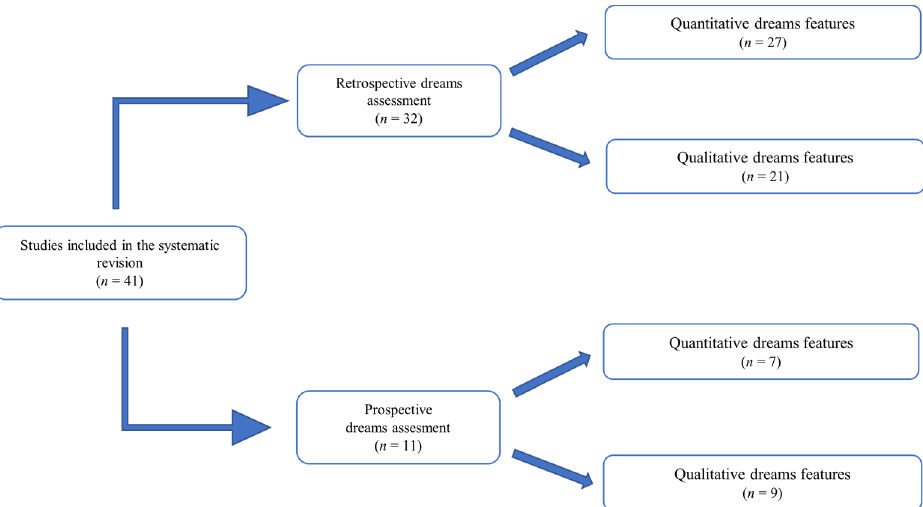
Figure 1. Studies categorization. Among 41 studies analyzed, 32 studies performed retrospective dreams assessment [9,11–40] extracting quantitative [4,12–14,16–23,25–33,36–40] and